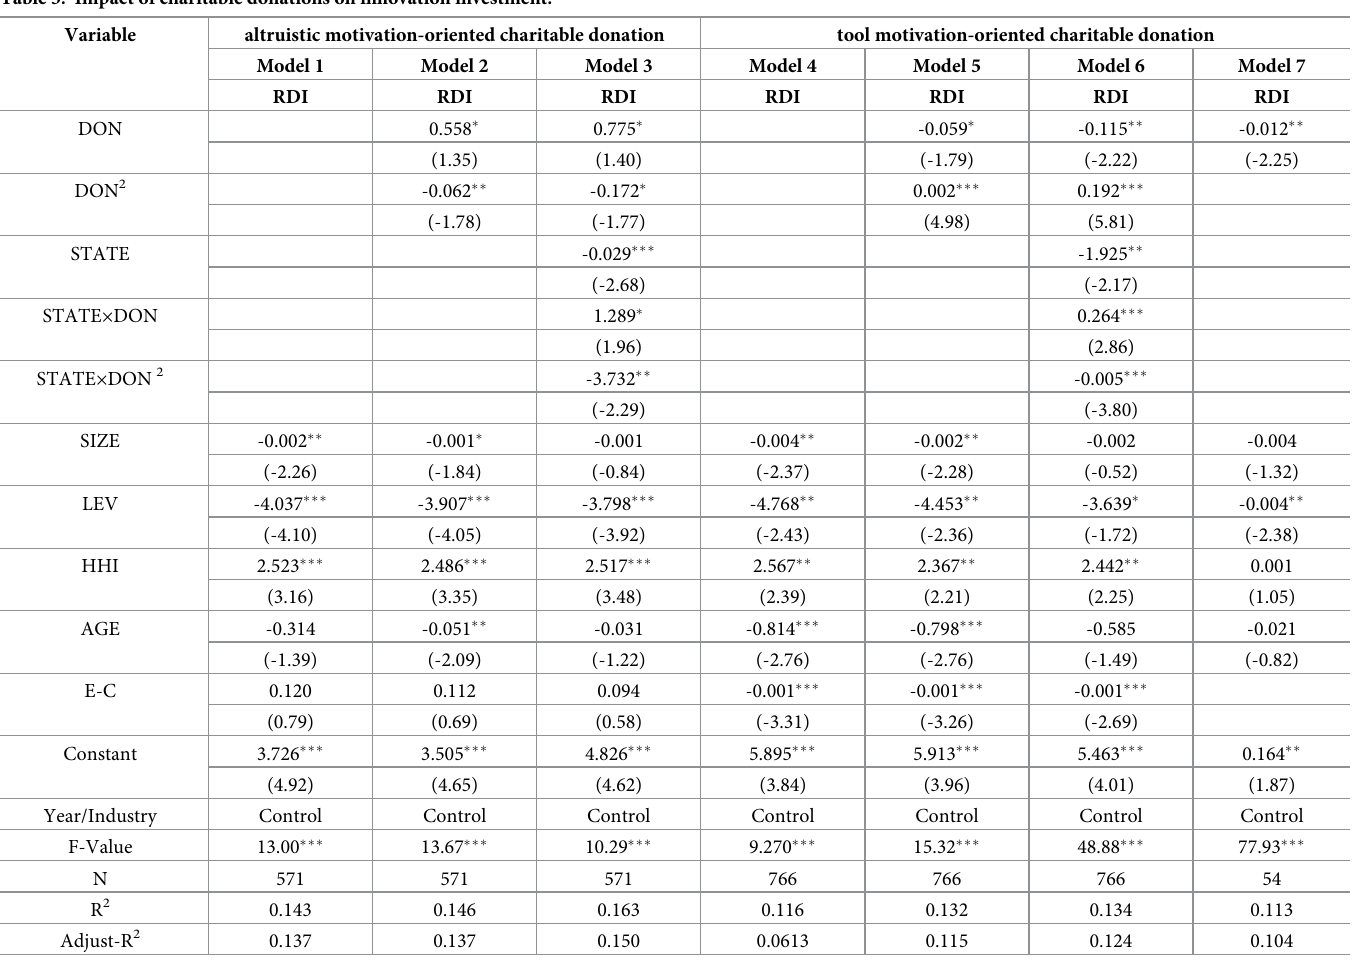
Table 5. Impact of charitable donations on innovation